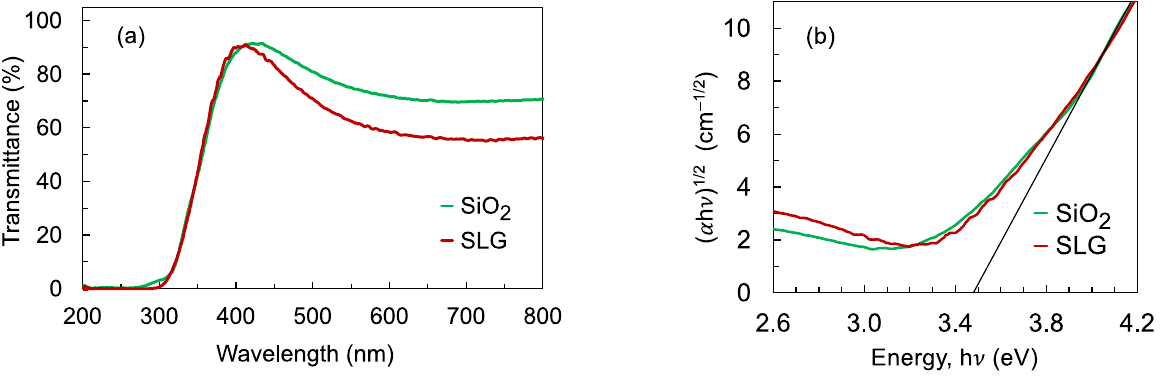
Figure 2. ( a ) Transmission spectra of the films deposited with a thickness of 80 nm on SiO 2 and SLG substrates; ( b ) Tauc plots showing a similar optical band gap energy of 3.48 eV for the films deposited on both SiO 2 and SLG substrates. The optical band gap was estimated from the x-intercept of the linear region.